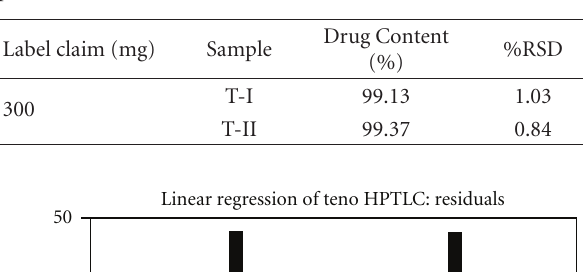
Table 5: Applicability of the HPTLC method for the analysis of the pharmaceutical formulations.